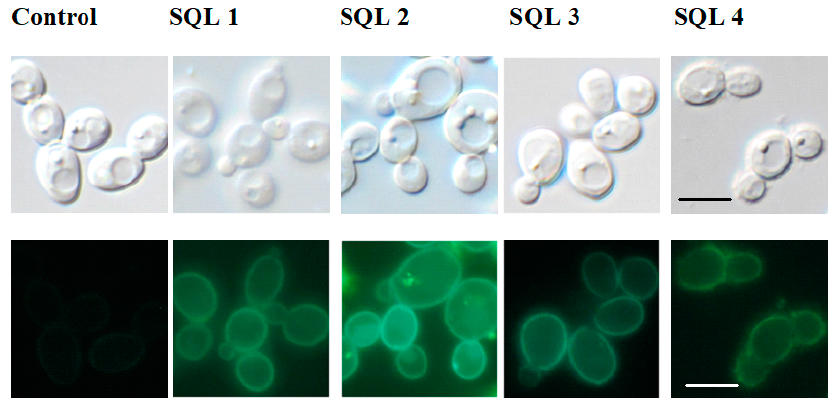
Figure 5. Microscopic imagining of the Candida albicans cells. Top panels: differential interference contrast; bottom panels: Cdr1p-GFP. Scale bars = 10 µ m.